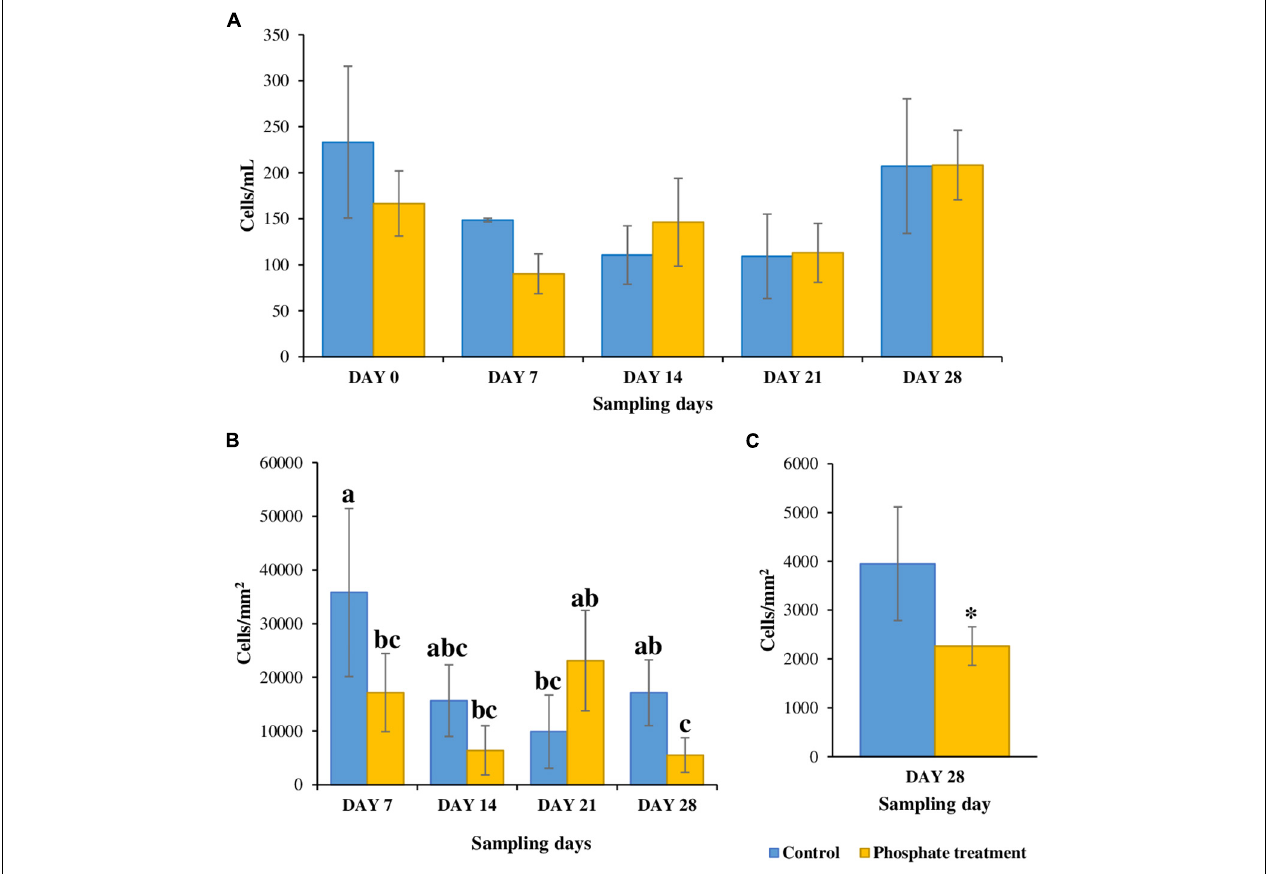
FIGURE 2 | Total cell count at different sampling points. (A) Water samples ( n = 5). (B) Biofilm samples from coupon’s inserts ( n = 3); samples with same letters (a, b or c) represent statistically non-significant samples while samples with different letters are significatively distinct. (C) Biofilm samples from sections ( n = 6), * shows significatively